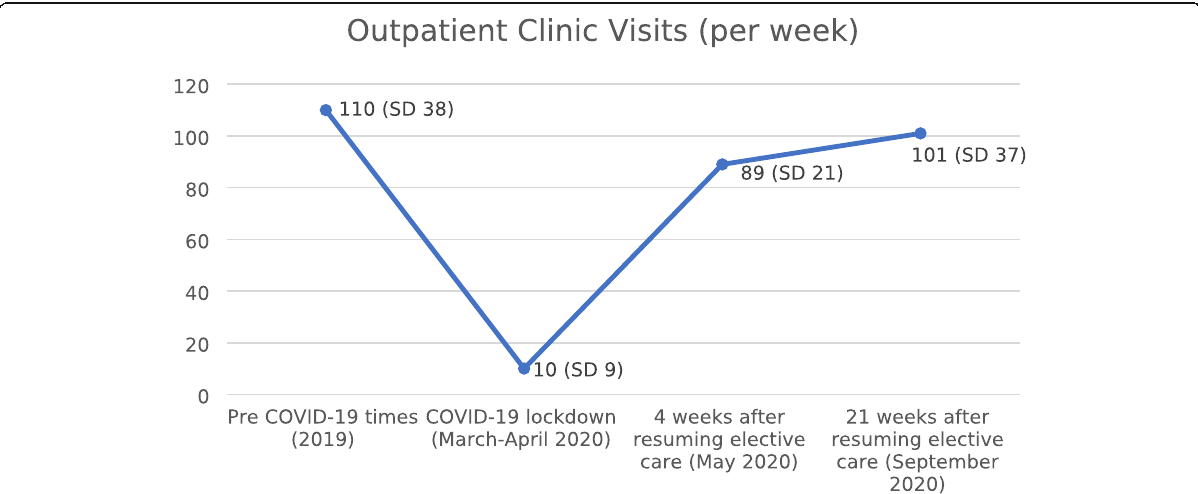
Fig. 2 Amount of outpatient clinic visits per week during: pre-COVID-19 times (March — April 2019); COVID-19 lockdown (March – April 2020); 4 weeks after resuming elective orthopaedic care (May 2020); 21 weeks after resuming elective care (September 2020; corresponding to 6 months after the introduction of first wave COVID-19